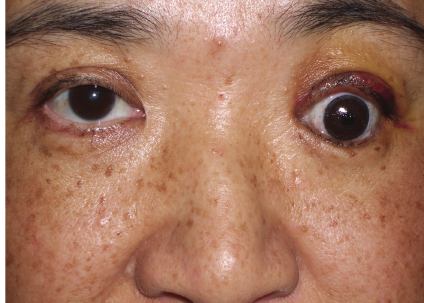
Figure 2: Postoperative 5 days after aponeurotic surgery (Case 1).